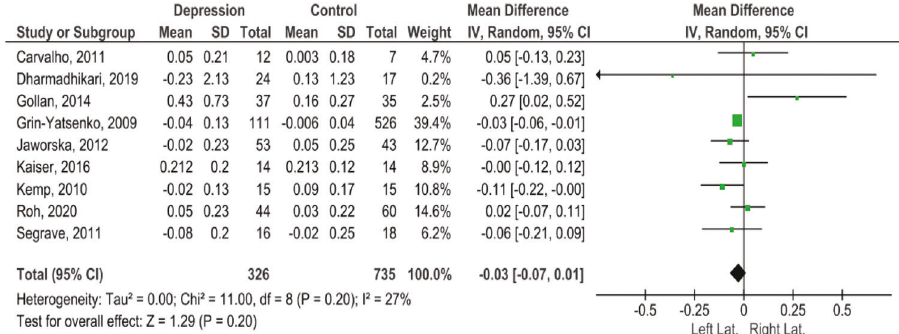
Fig. 2 Forest plot. Hemispheric lateralization in depression. The effects shown in these data did not con fi rm hemispheric lateralization in depressed patients.